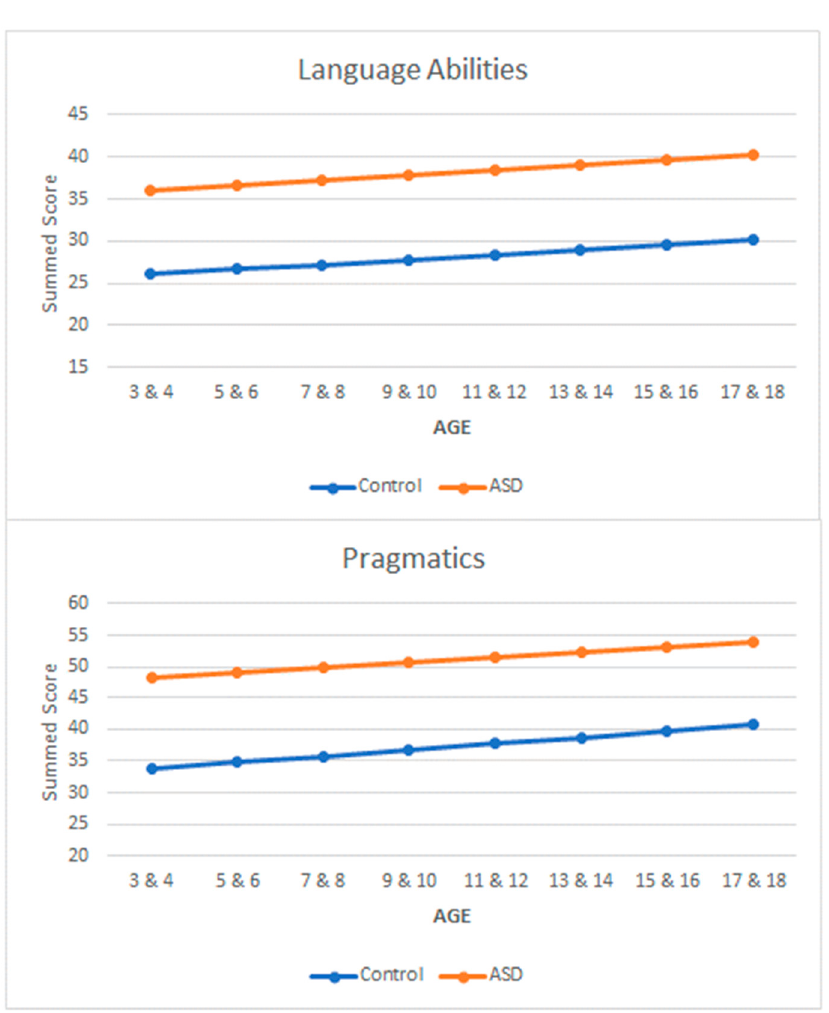
Figure 5. Interpretation plots based on the combined data from Experiments 1 and 2.